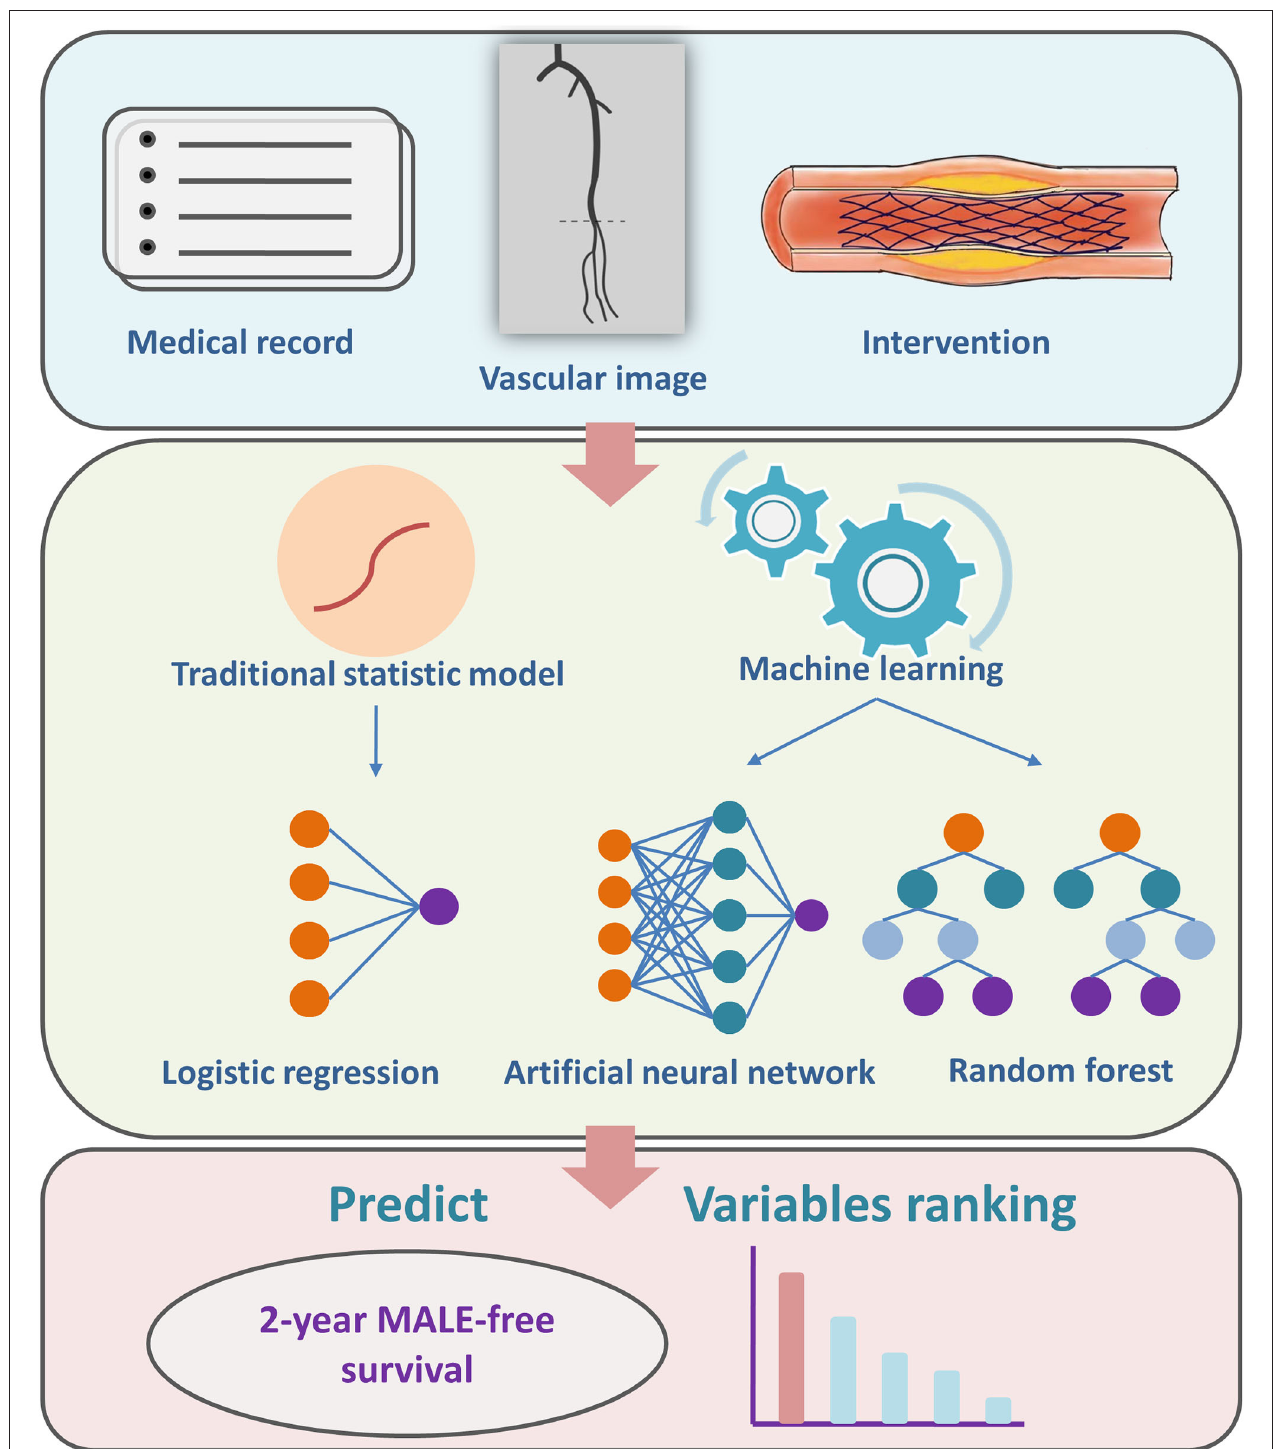
FIGURE 1 | A brief summary of study design and machine learning model development. MALE, major adverse limb event.